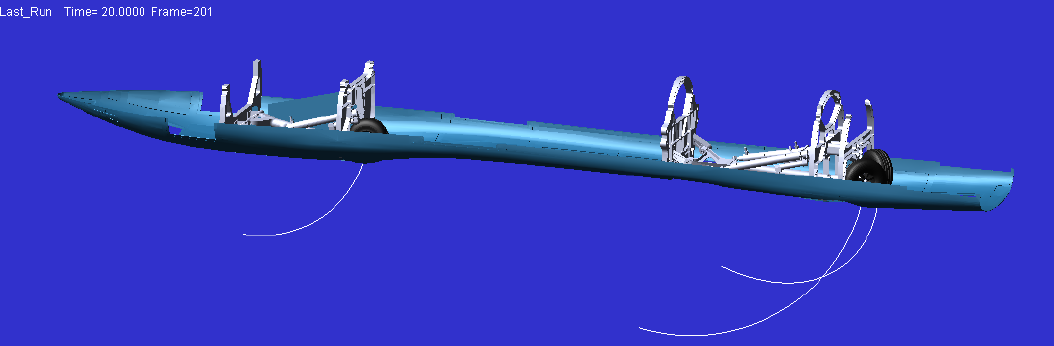
Figure 5. Modelling of aircraft with landing gears in extended configuration.